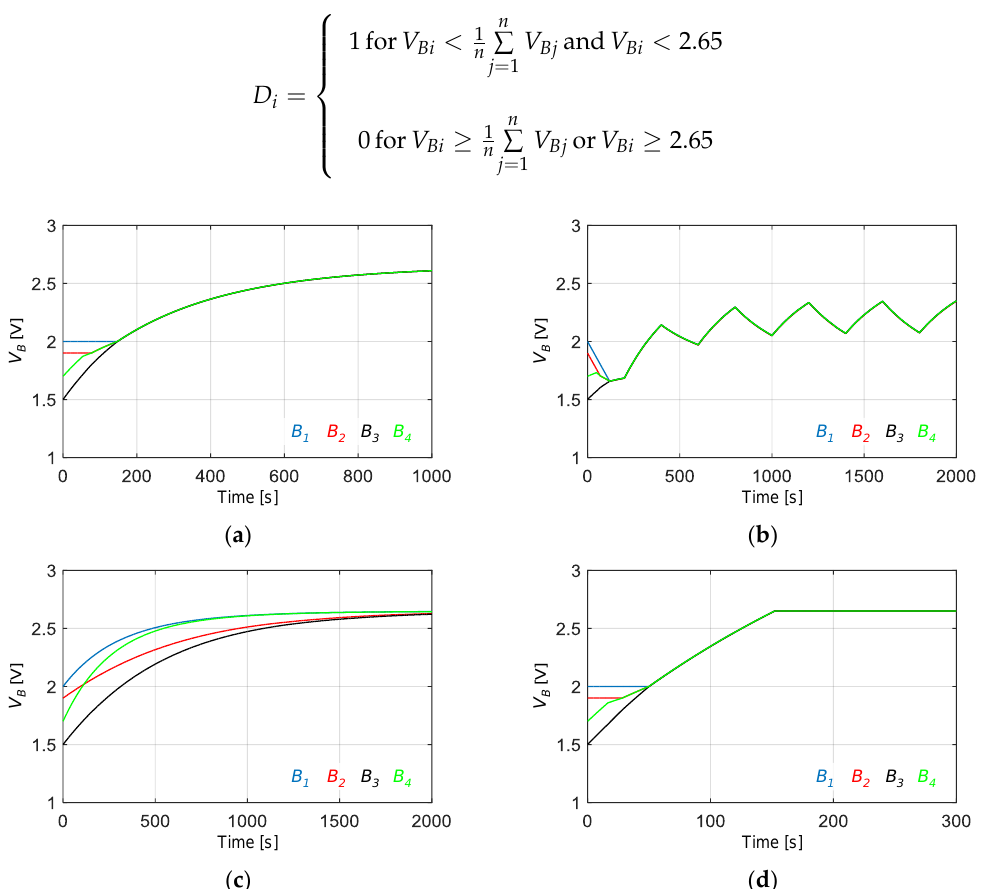
Figure 9. EDLC cell voltage, charged by the closed-loop SIMO SC converter; ( a ) with an input source voltage of 3.4 V and control logic in Equation (14); ( b ) with a dynamic string load; ( c ) with pulse-dropping control, D 1 = D 4 = 1, and D 2 = D 3 = 0.5; and ( d ) with an input source voltage of 5 V.